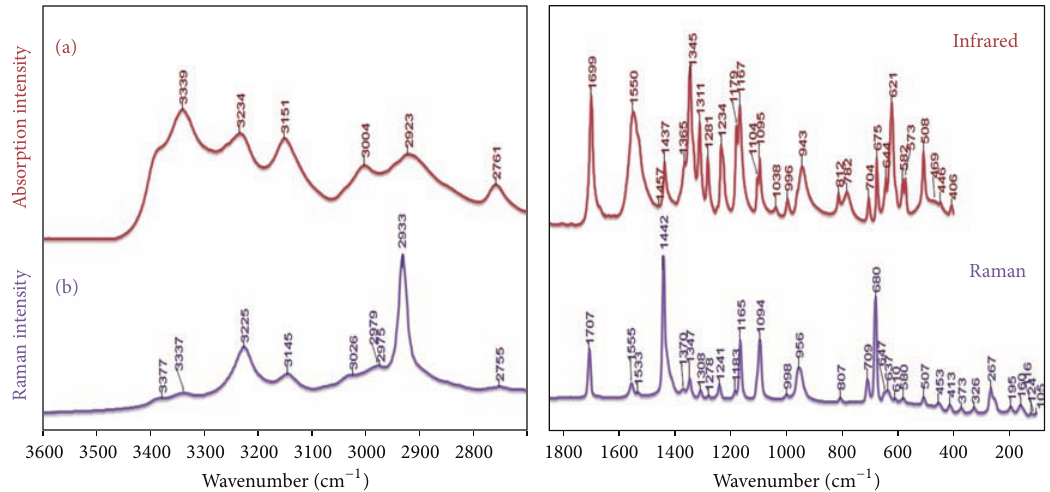
Figure 4: Experimental FT-IR (a) and micro-Raman spectra (b) of acetazolamide in the regions 3600–2800 cm −1 and 1800–200 cm −1 , respectively.